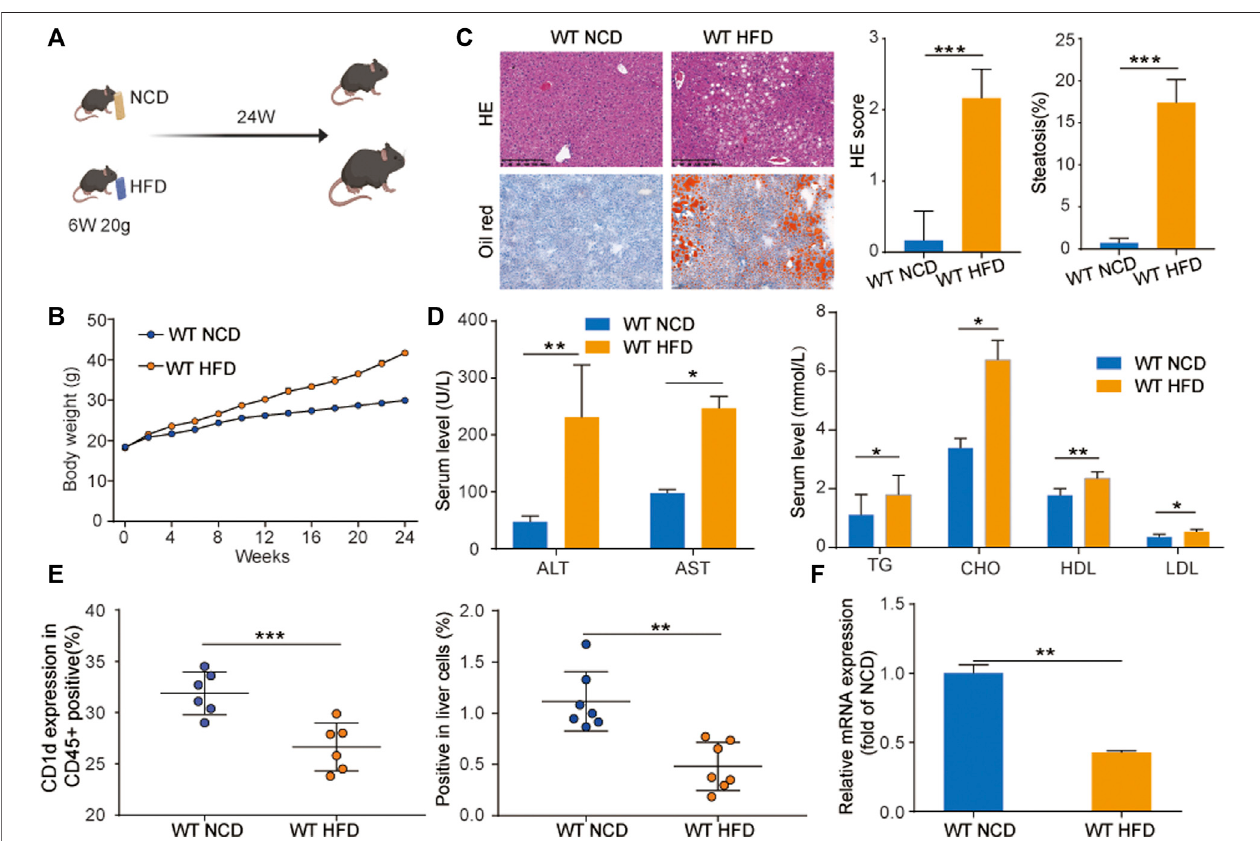
FIGURE 1 | CD1d was decreased in WT-NAFLD mice. (A) WT mice were divided into two groups and fed with NCD and HFD separately for 24 weeks. (B) Body weight gain curve of WT-NCD mice and WT-HFD mice. (C) Liver injury and serum lipid indicators. ALT, AST, TC, TG, HDL, and LDL levels in mice serum (D) . The liver morphology,H&Estainingand OilRedstaining, (E) CD1d surfacemarkerexpression inmouse CD45 + immunecells andmice livercells. (F) TheRNAexpression levelof CD1d expression between WT-NCD mice and WT-HFD mice. ALT, alanine aminotransferase; AST, aspartate aminotransferase; HDL, high-density lipoprotein; H&E,hematoxylin and eosin;HFD, high-fat diet;LDL, low-densitylipoprotein;NCD,normalcontroldiet; PBMC,peripheral blood mononuclearcell; TC, total cholesterol; TG, triglyceride; WT,